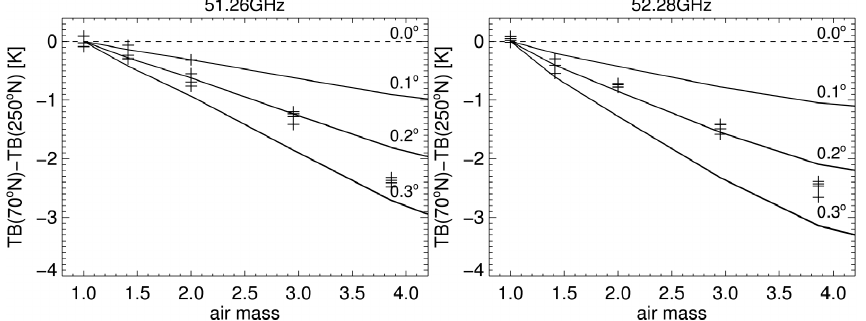
Fig. 8. Lines: radiative transfer calculations at different air masses for four clear sky radiosondes launched at 09:27, 10:39, 12:03, and 13:44LT on 16 August 2009. Air masses are modified in order to simulate a tilt t of the radiometer by 0.1, 0.2, 0.3 ◦ : 1T b = T b (el=el + t ) − T b (el=el − t) , (el=elevation). Crosses: mean HATPRO-G2 measurements during radiosonde ascents (5min before and 1h after each launch). Radiative transfer calculations corrected air mass values; the antenna beam width and exact band-pass filters are